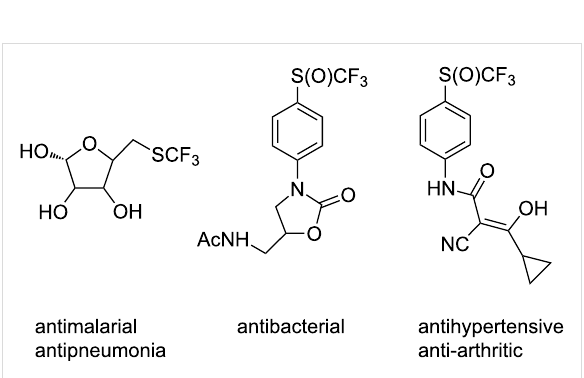
Figure 1: Examples of industrial fluorine-containing bio-active molecules.